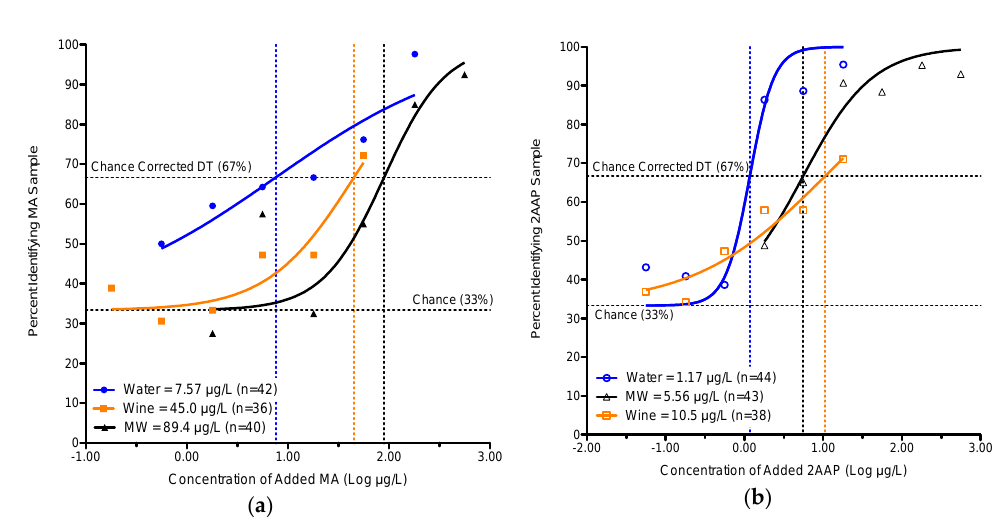
Figure 1. Detection Thresholds (DTs) across the three matrices. The sigmoidal curve fittings of group responses for the forced-choice tasks were calculated using the Hill equation. Separate fits are shown for: ( a ) methyl anthranilate and; ( b ) 2-aminoacetophenone in water (blue circle), model wine (black triangles) and wine (orange